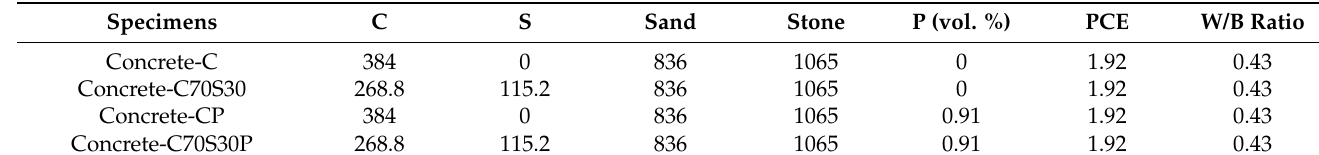
Figure 2. The preparation and service environment simulation of CBRM specimens. Table 2. The mix ratio of CBRM-Paste.